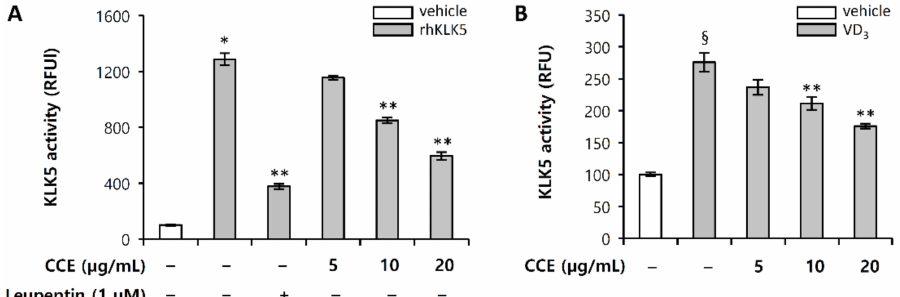
Figure 3. CCE inhibit KLK5 protease activity. KLK5 activity was measure in relative fluorescence units (RFU), using fluorogenic peptide substrate sensitive to KLK5. ( A ) Recombinant human